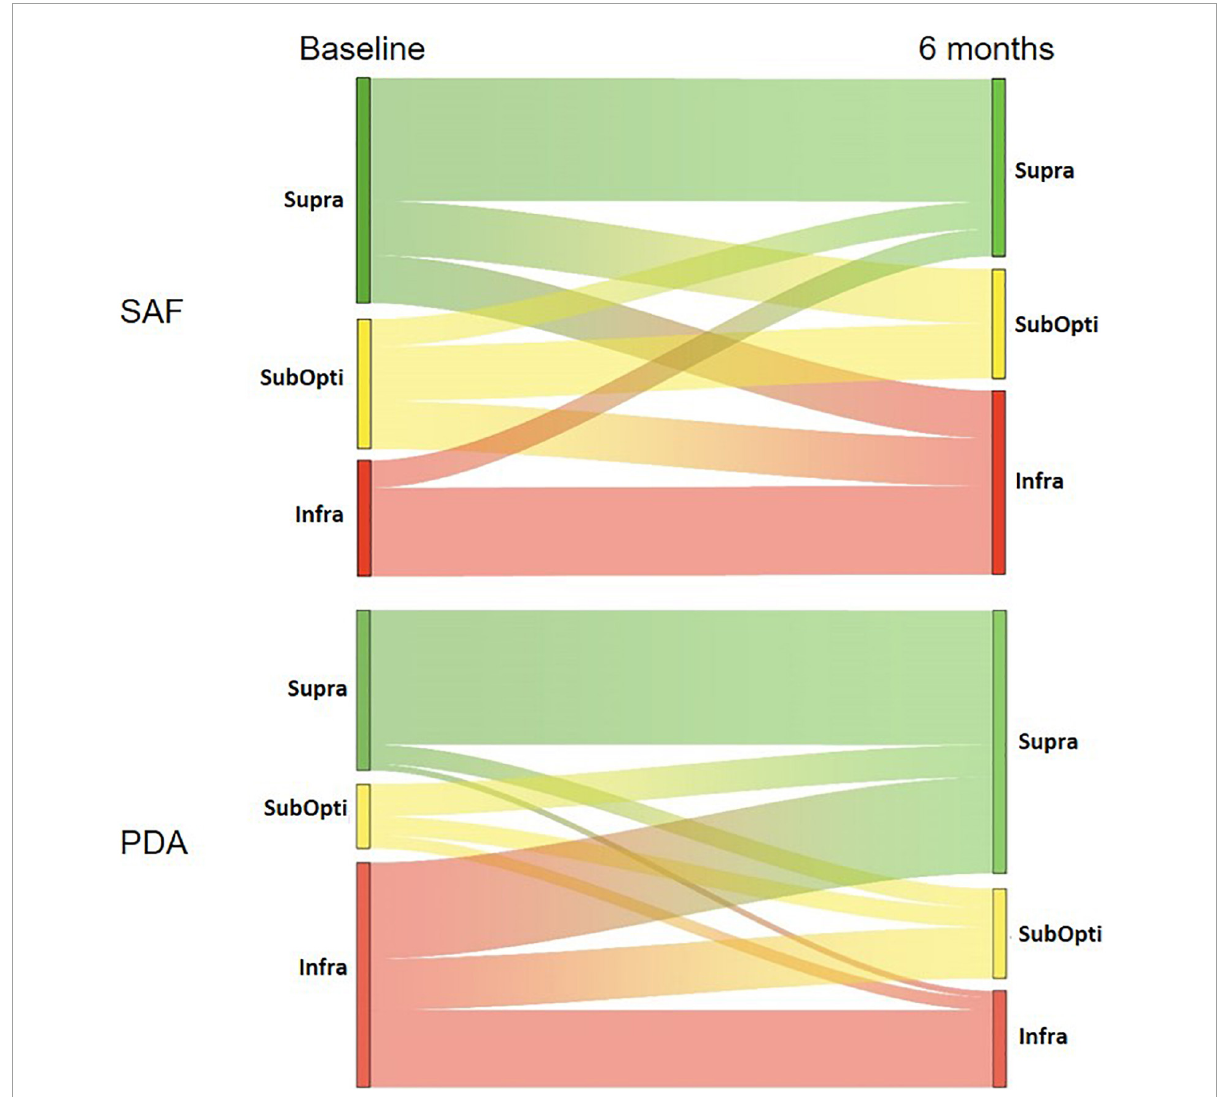
FIGURE3 Sankey diagrams showing the interclass evolution of patient according to the ANSES 2016 recommendations. Patients were classified into InfraRDA, SubOptiRDA or SupraRDA at baseline and 6 months. Interclass evolution during follow-up is depicted in SAF and PDA groups. For each class, the height of bars corresponds to the number of patients (see Table 4